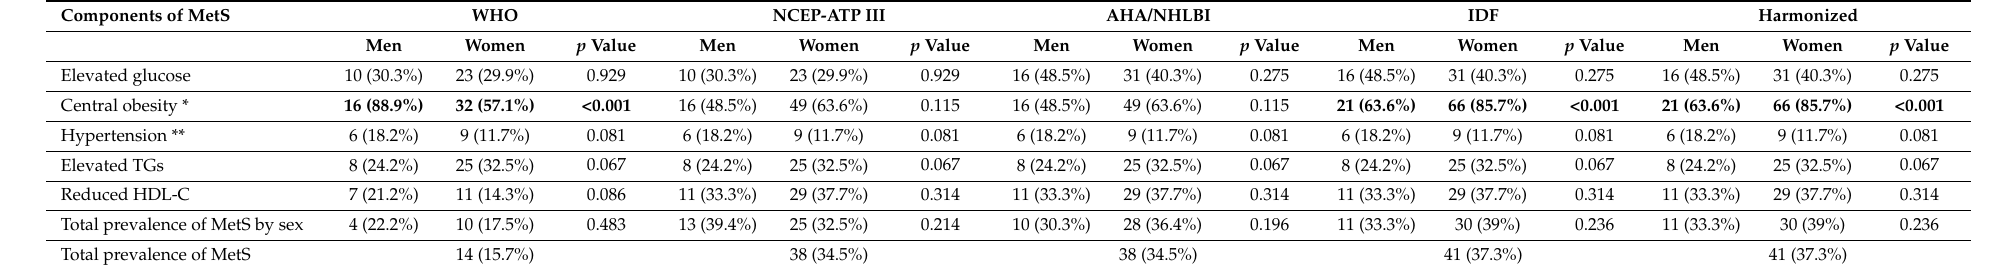
Table 3. Prevalence of metabolic syndrome and the percentage of participants ( n = 110) with individual components of metabolic syndrome by the WHO, NCEP ATP III, AHA/NHLBI, IDF, and Harmonized criteria, respectively. WHO